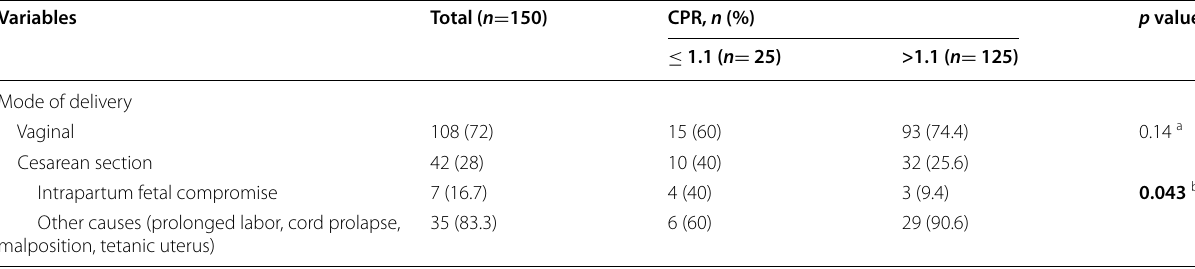
CPR cerebroplacental ratio a p values are based on chi-square test. Statistical significance at p < 0.05 b p values are based on Fisher’s exact test. Statistical significance at p < 0.05